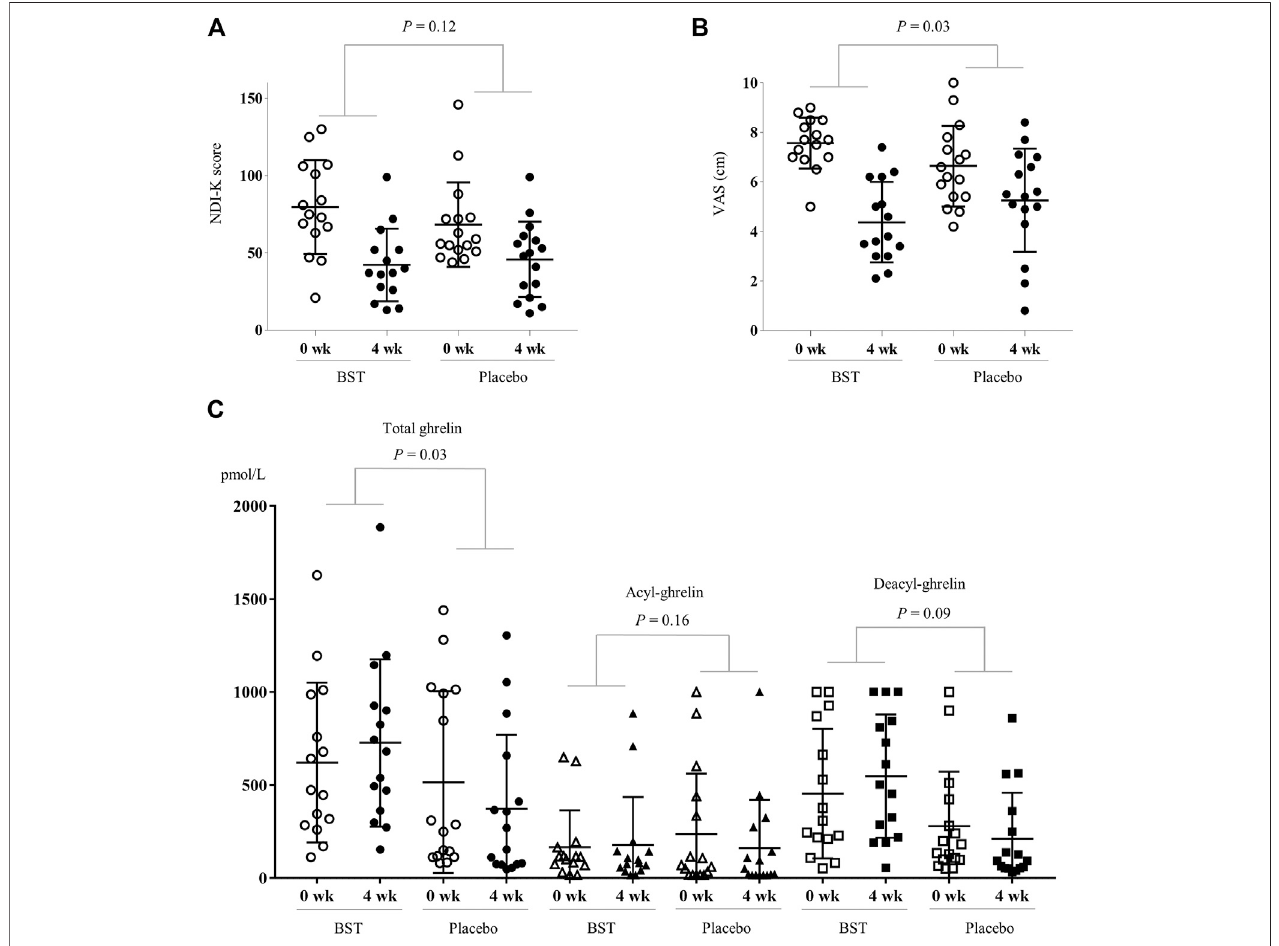
FIGURE 3 | Change of measurements in BST and placebo group. The changed values were analyzed using Independent t -test for NDI-K score (A) , VAS (B) , and plasma ghrelin levels (C) .